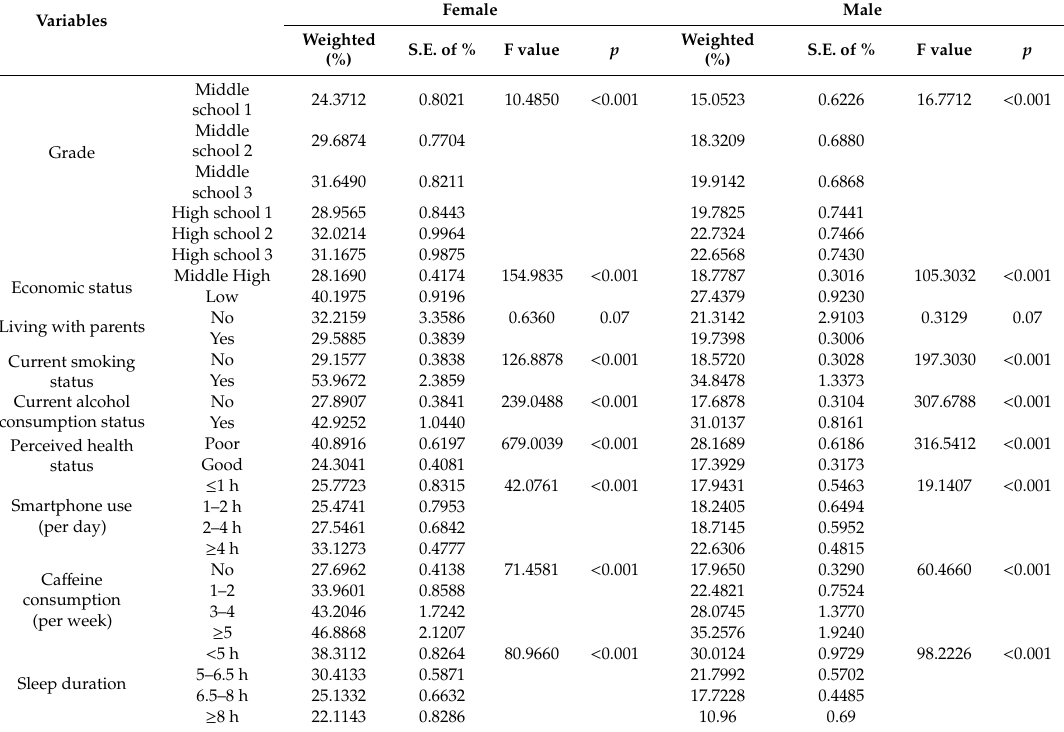
Table 3. Risk factors for